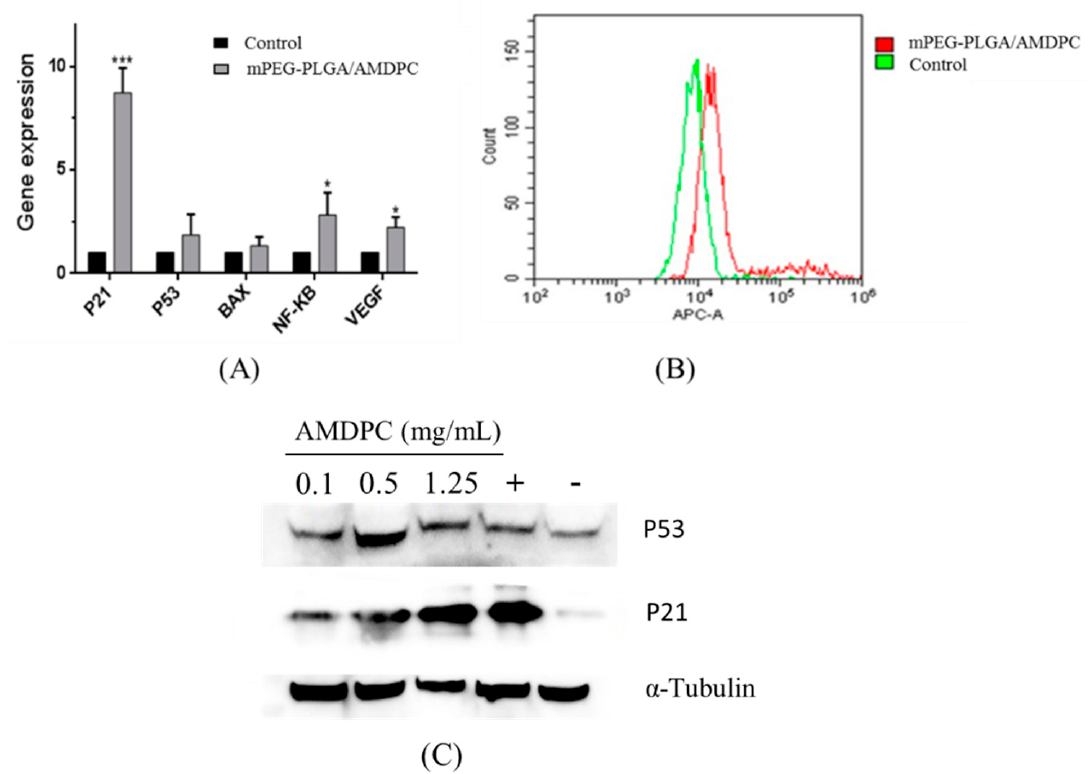
Figure 5. ( A ) The mPEG-PLGA/AMDPC affected gene expression related to the growth and apoptosis of BCAP-37 cells. Cells were treated with 50 μ g/mL of AMDPC for 36 h. ( B ) Effect of mPEG- PLGA/AMDPC on P21 proteins of BCAP-37 cells, using flow cytometry analysis. ( C ) Western blots analysis of P21 protein after treatment with mPEG-PLGA/AMDPC on BCAP-37 cells. ( D )